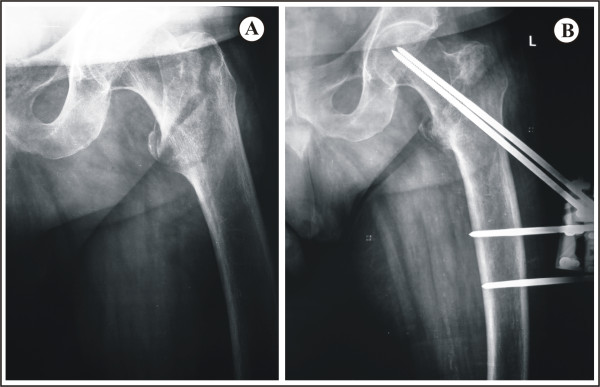
Clinical case with proximal screws placed in a parallel way. A. Anteroposterior view of an AO Type I intertrochanteric fracture in an 75-year old man. B. Anteroposterior view following fixation of the fracture with the proximal screws placed in a parallel way.